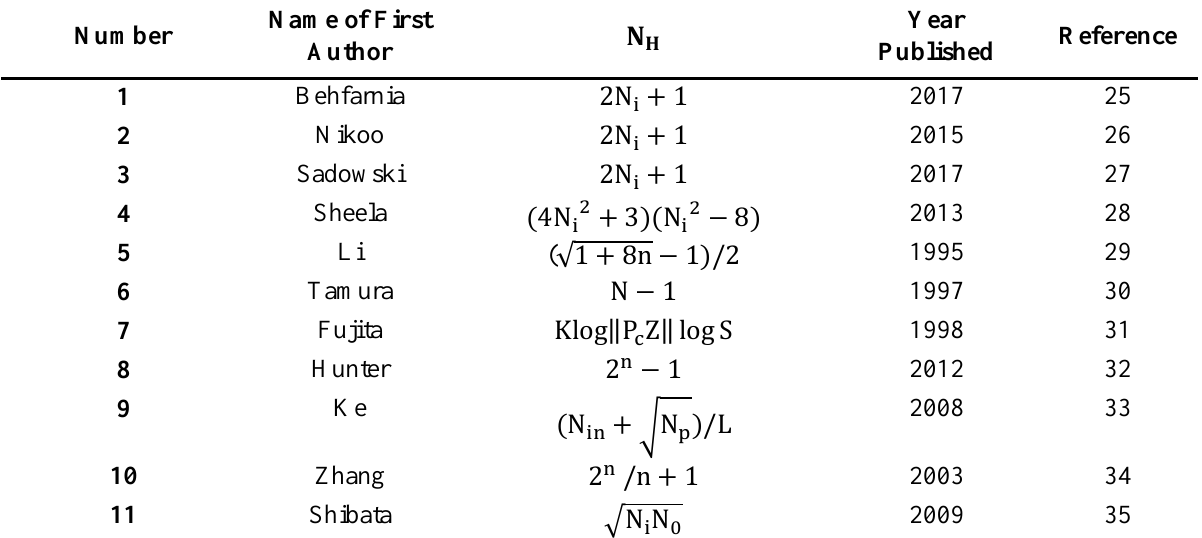
Empirical Formulas for Determining Number of Hidden Neurons (N